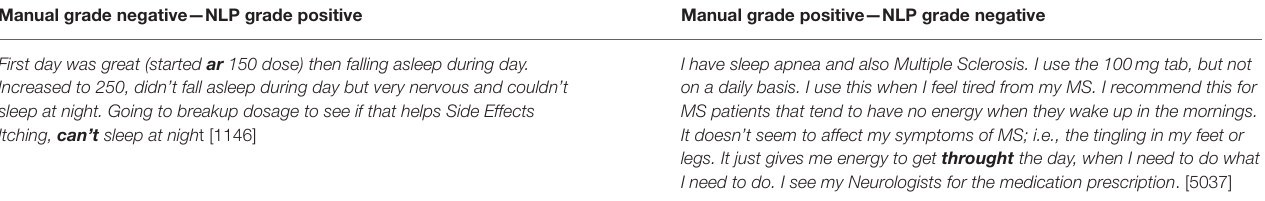
TABLE 11 | Example posts with conflicting sentiment analysis results. Manual grade negative—NLP grade positive Manual grade positive—NLP grade